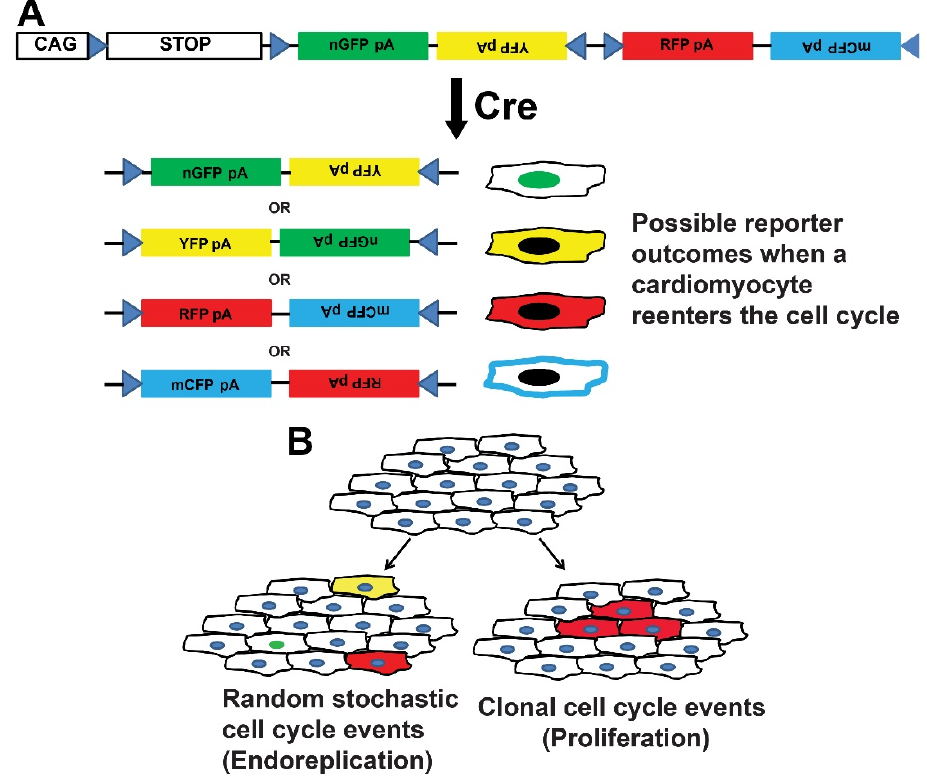
Figure 6. CAG-loxP-STOP-loxP-Confetti (Brainbow). ( A ) The tamoxifen-induced expression of Cre- dependent causes stochastic recombination of a multi-fluorescent reporter. Identifying of clusters of cells expressing the same fluorescent reporters are used to infer clonal expansion. ( B ) Schematic of the interpretation of Confetti expression used to identify random stochastic events ( left ) and clonal expansion consistent with proliferation ( right ).